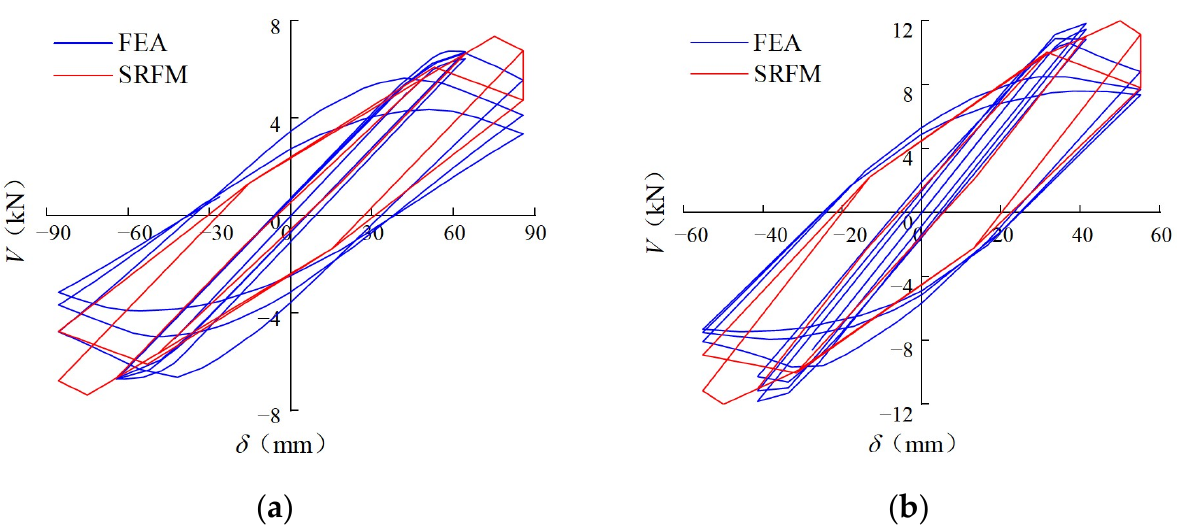
Figure 31. The comparison on the hysteresis curves between FEA model and SRFM for members failed with distortional and global coupling instability. ( a ) C3-BC-L70-60-02. ( b ) C4-BC-L50-70-02. 6. The comparison on the hysteresis curves between the proposed SRFM and the FEA model for CFTWS lipped channel members failed with local and global coupling instability is shown in Figure